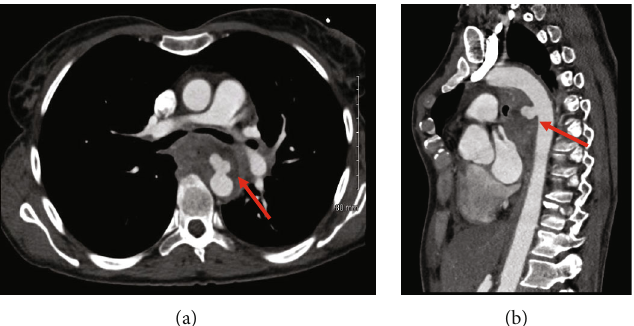
Figure 1: Axial (a) and sagittal (b) CT angiogram images demonstrating extravasation of contrast anteriorly into the surrounding esophageal tumour.